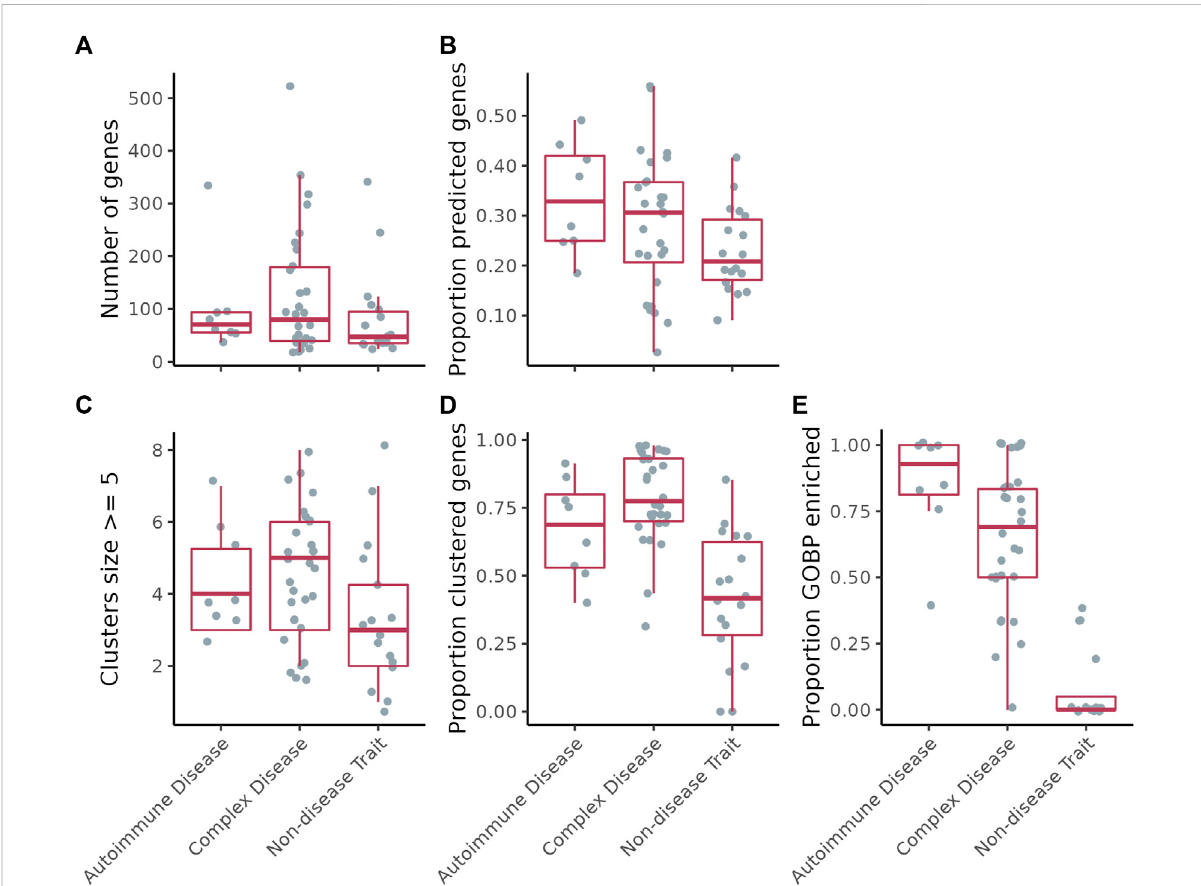
FIGURE 2 (A) Number of genes per disease/trait. (B) Proportion of the genes per disease/trait that were predicted by GenePlexus. (C) Number of clusters per disease/trait containing at least fi ve genes. (D) Proportion of total genes assigned to a cluster containing at least fi ve genes. (E) Proportion of clusters per disease/trait enriched with genes from at least one GO biological